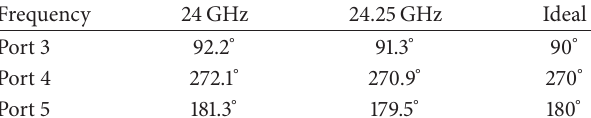
Table 1: Normalized phase difference at the output ports.